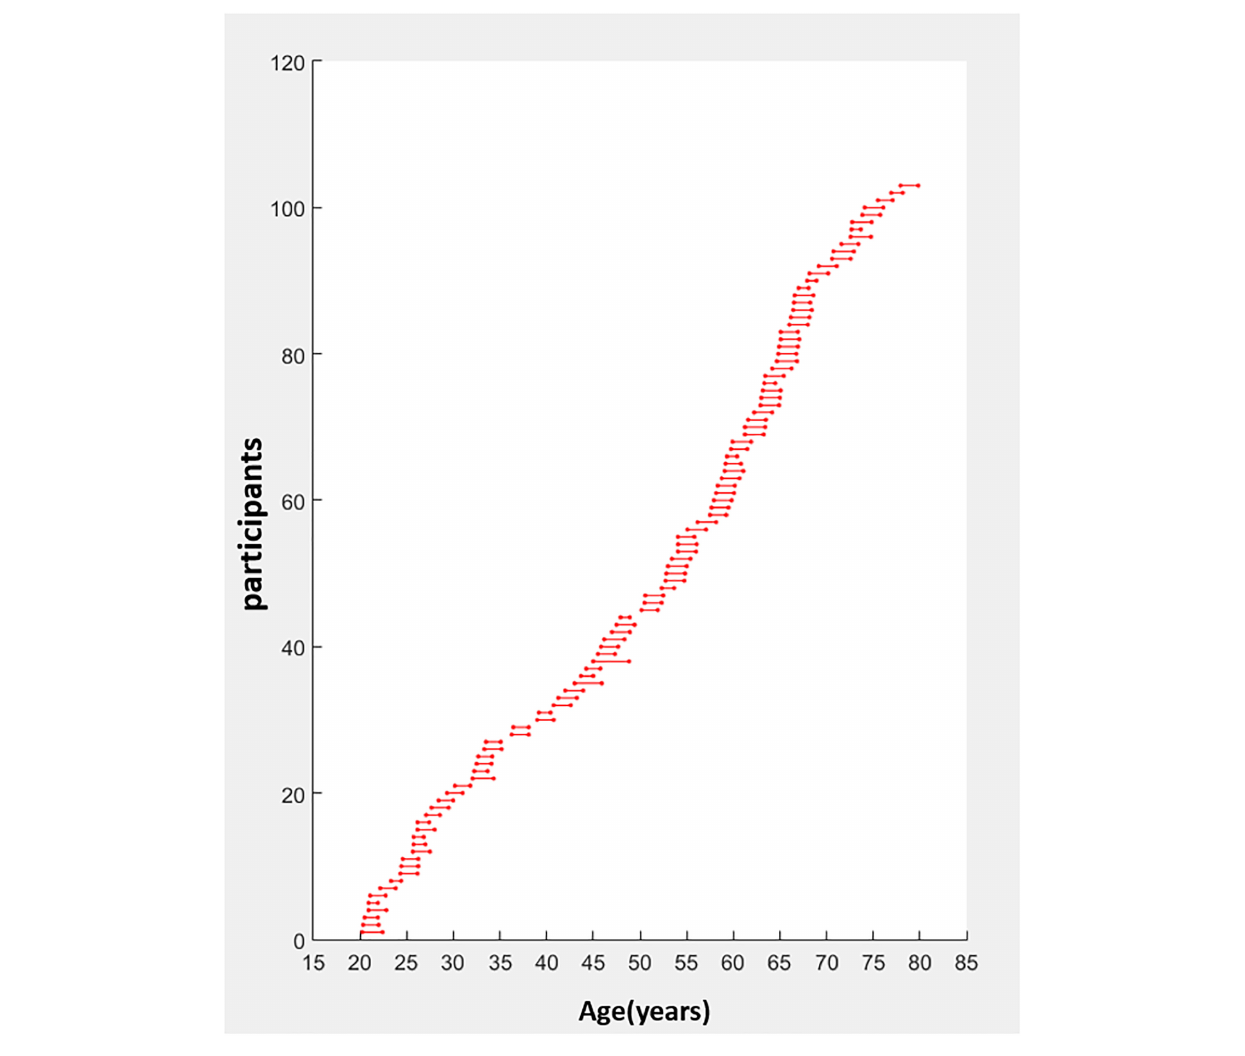
FIGURE 1 | Age distribution of the longitudinal data (years). Participants aged 20–78 years old ( n = 102) had a 3T MRI scan and completed cognitive tests at two time points, an average interval of 1.79 years apart (standard deviation = 0.37 year; range: 1–3.83 years). The age at each scan is indicated by a circle. The first scan is the leftmost with the repeated scan directly to the right and joined by a horizontal